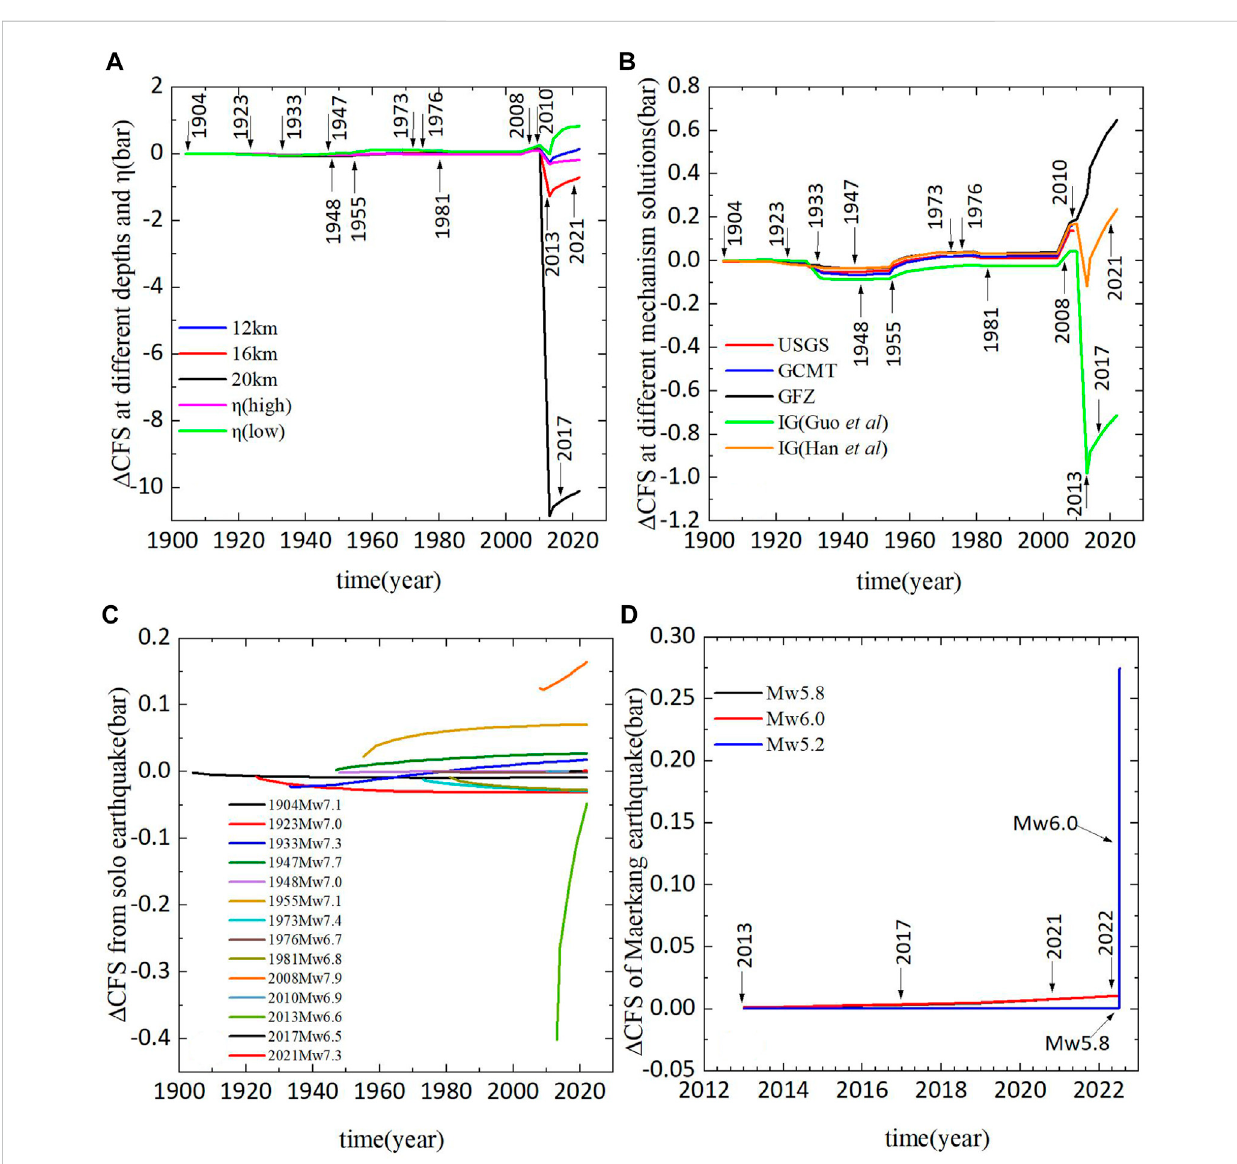
FIGURE 3 Trendoftheviscoelastic Δ CFSovertime. (A) Δ CFStrendattheepicenterofthe2022Lushanearthquakefordifferentdepthsandviscosities. (B) Δ CFS trend at the epicenter of the 2022 Lushan earthquake with different focal mechanism solutions. (C) Δ CFS trend at the epicenter of the 2022 Lushan earthquake from each historical earthquake. (D) Δ CFS trend at the epicenters of the three 2022 Maerkang